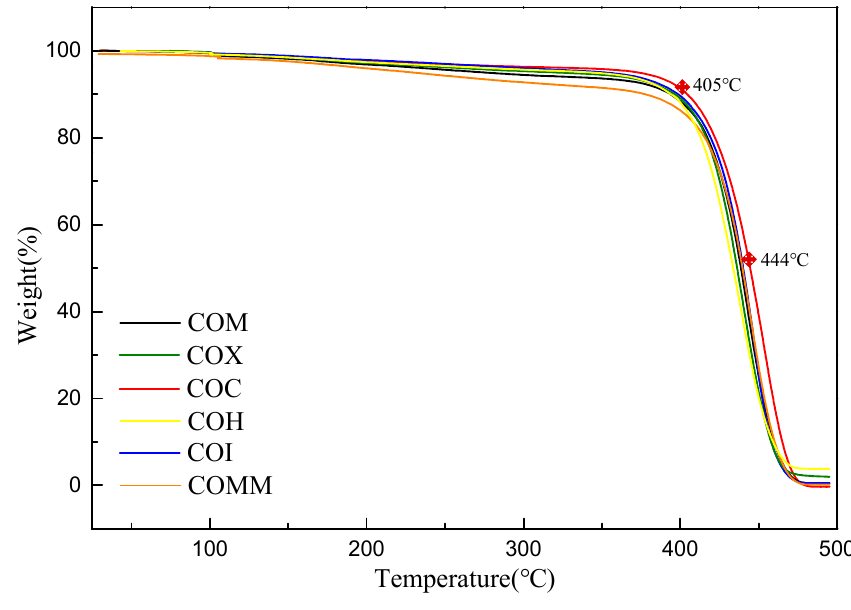
Figure 3. TGA Of PA6 containing cyclic compounds.